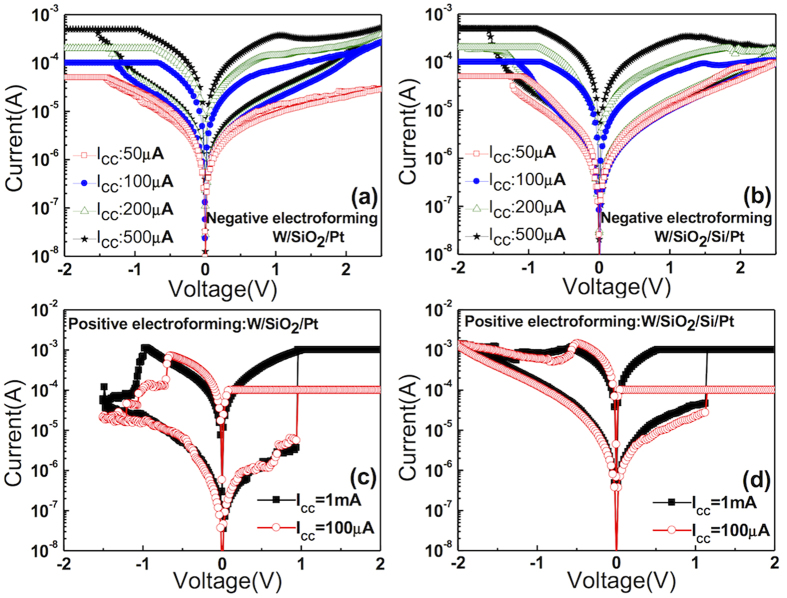
The RS I-V curves with various Icc (50 μA −500 μA) after negative electroforming in (a) W/SiO2/Pt and (b) W/SiO2/Si/Pt. The I-V curves after positive electroforming with Icc of 100 μA and 1 mA in (c) W/SiO2/Pt and (d) W/SiO2/Si/Pt.